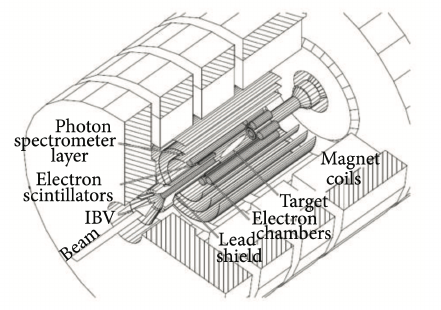
Figure 12. Schematic of the MEGA experiment (Figure from [163]).